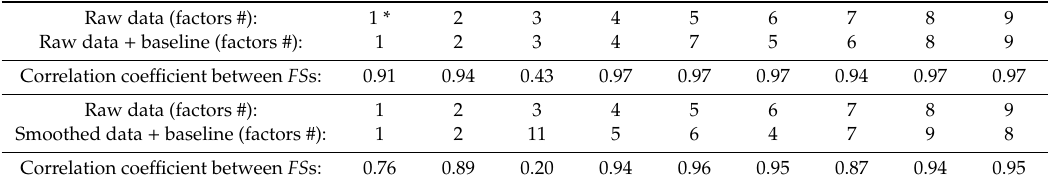
* Factor numbers correspond to the rank in a series arranged in descending order of the data dispersion explained by the factor.